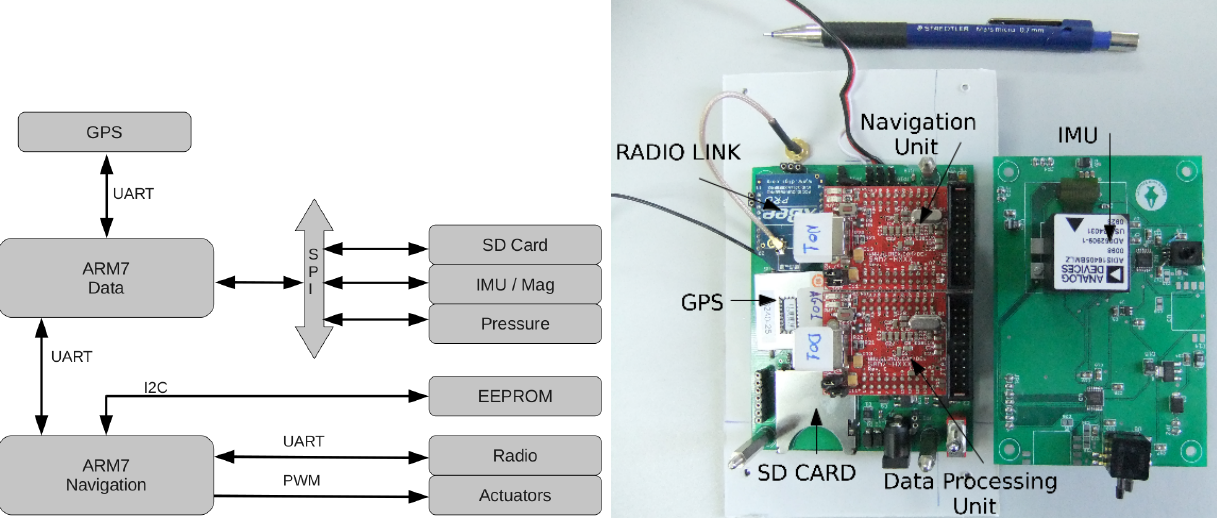
Figure 10. Functional diagram of the autopilot and its hardware implementation.